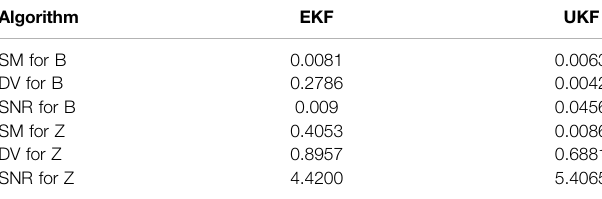
TABLE 1 | Comparison of fi ltering effects of EKF and UKF methods. Algorithm EKF UKF SM for